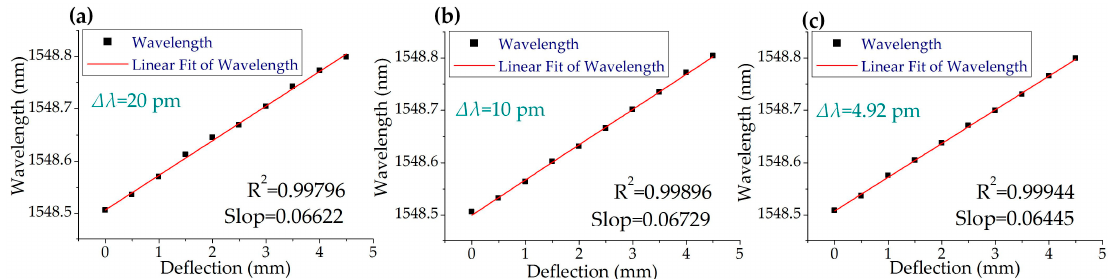
Figure 8. Interrogating results of FBG strain sensing with a reference FBG at different swept steps. ( a ) ∆λ = 20 pm. ( b ) ∆λ = 10 pm. ( c ) ∆λ = 4.92 pm.